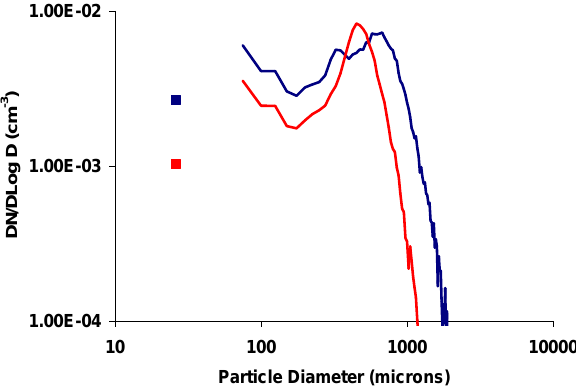
Fig. 6. Cloud Particle size distributions from the 2DC (lines) and the CDP (points) for the period 05:22 to 05:32 UTC (blue, during flight segment “a” in Fig. 1), 05:42 to 05:52 UTC (red, during flight segment “b” in Fig. 1). The CDP registered too few counts to pro- duce a continuous size distribution, so the total concentration from the instrument is included at the midpoint of the sampling range.